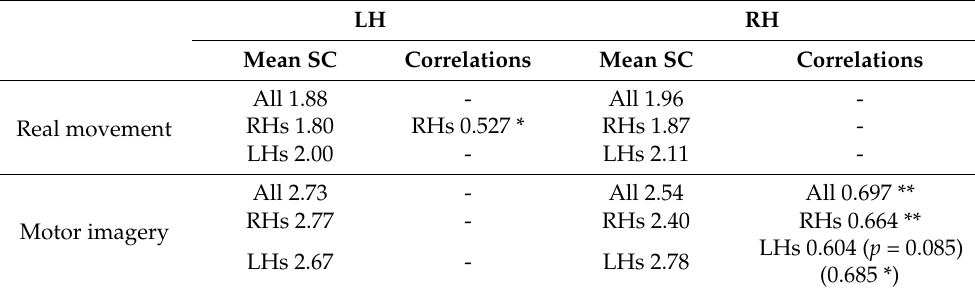
Table 4. Mean values of subjective complexity (mean SC) and Spearman’s correlation coefficients (correlations) between SC of real movement or motor imagery of the right hand (RH) or left hand (LH) and the accuracy of classification of brain states during imagination of movements of the left hand compared with right hand (ARLH) in the group of all participants (all), in the group of “pure” right-handers (RHs) and latent left-handers (LHs).